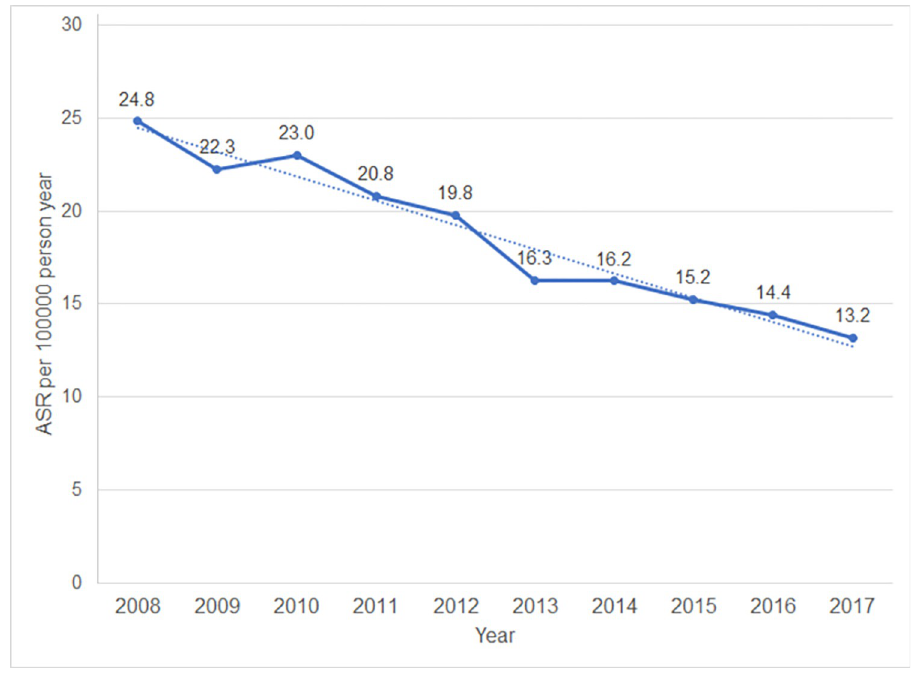
Fig 2. Trends in the incidence of cervical cancer in upper northern Thailand.